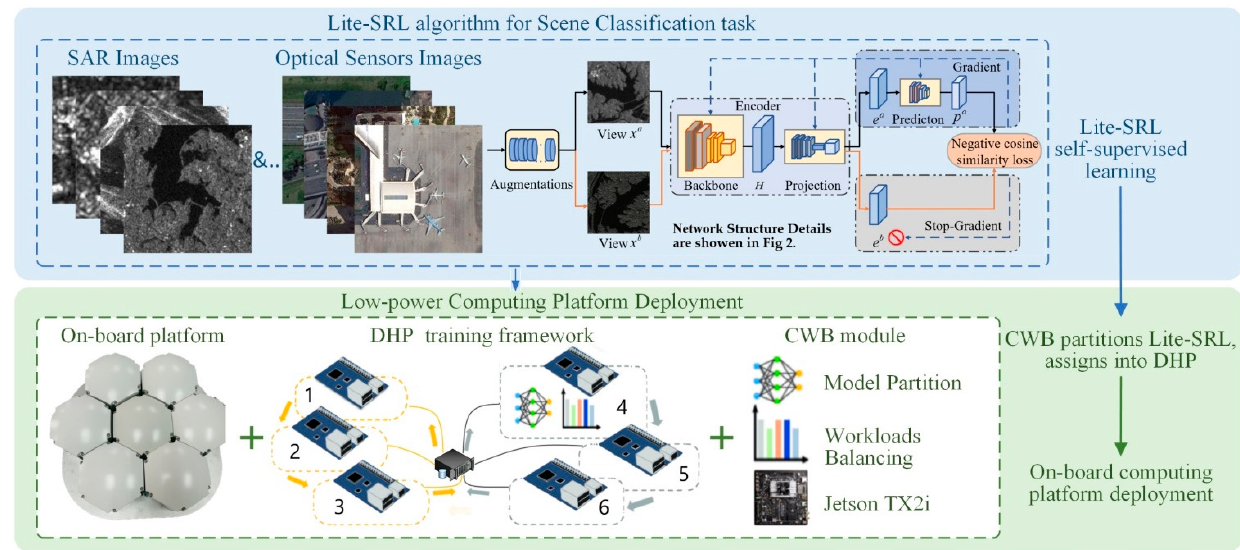
Figure 1. Overview of the proposed work. Lite-SRL: on-board self-supervised representation learning algorithm for RSSC task; CWB: computation workload balancing module; DHP: on-board distributed hybrid parallelism training framework.